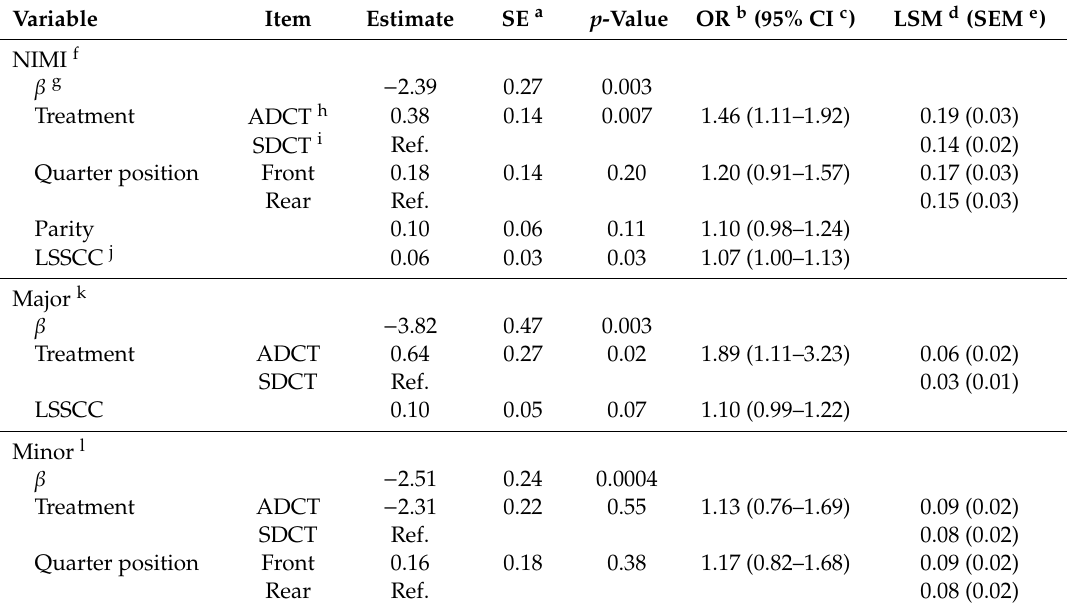
Table 6. Logistic regression for the e ff ect of drying o ff protocols on overall NIMI risk and by group of pathogens identified at 7 ± 3 and 14 ± 3 d